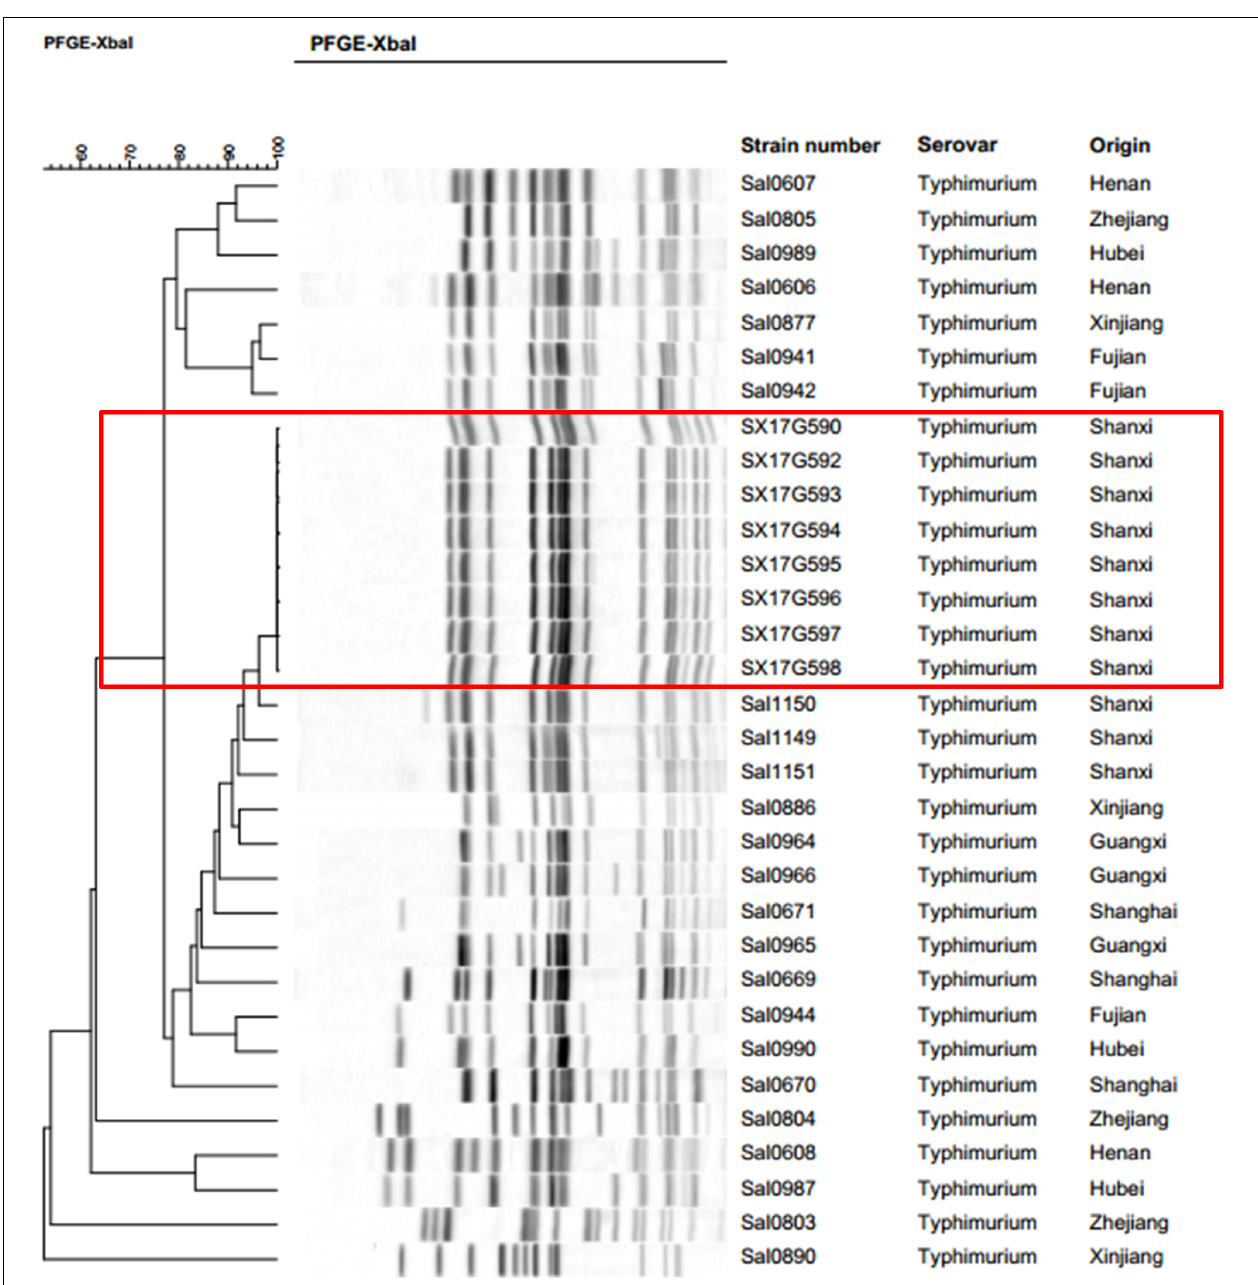
FIGURE 1 | Pulsed-field gel electrophoresis (PFGE) patterns created by digestion with the enzyme Xba I. Dendrogram showing the level of genetic relatedness based on the unweighted paired arithmetic averaging method using average linkages and the dice coefficient for S . Typhimurium strains.